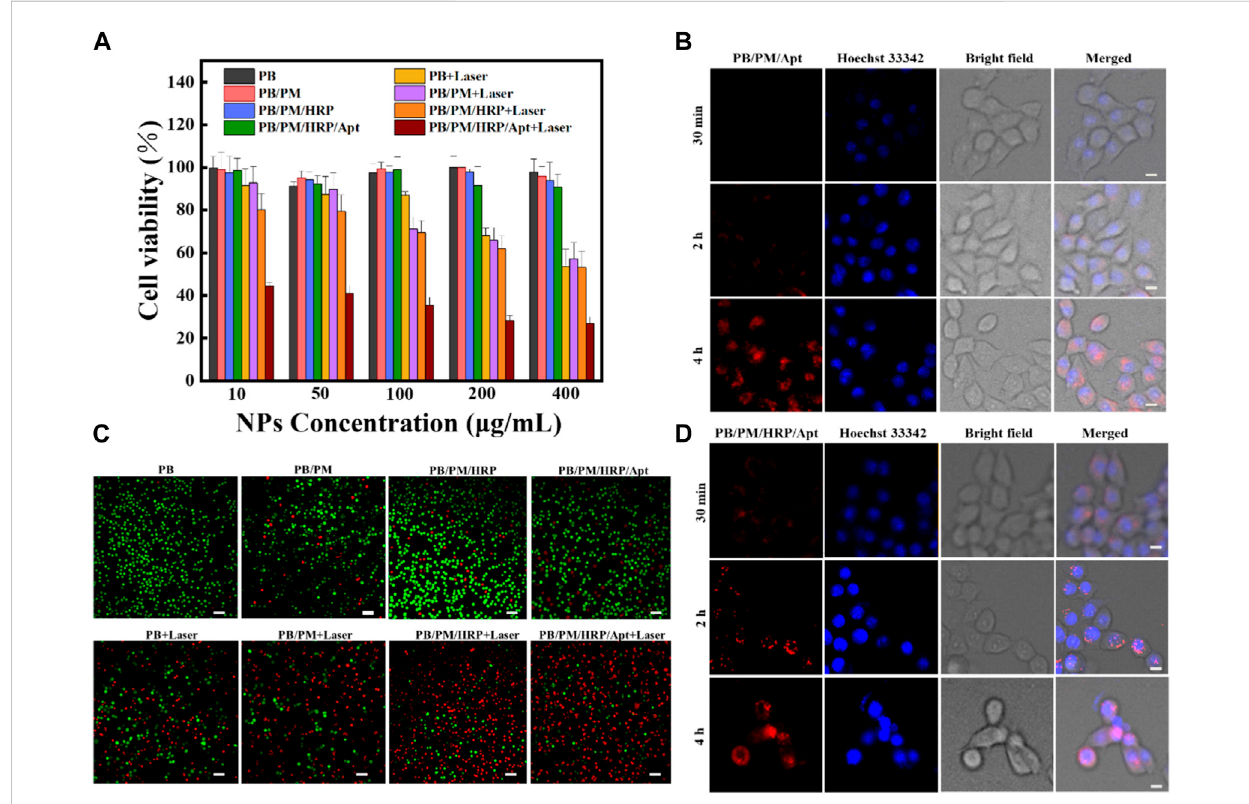
FIGURE 5 In vitro cytotoxicity assessment. (A) Viability of 4T1 cells treated with free PB, PB/PM, PB/PM/Apt, PB/PM/HRP/Apt and laser irradiation. (B) Confocal fl uorescence images of 4T1 cell viability determined by different treatments. Scale bar: 50 μ m. (C) Confocal fl uorescence imaging of 4T1 cells treated with PB/PM/Apt at different incubation times. Scale bar: 10 μ m. (D) Confocal fl uorescence imaging of 4T1 cells treated with PB/PM/HRP/Apt at different incubation times. Scale bar: 10 μ